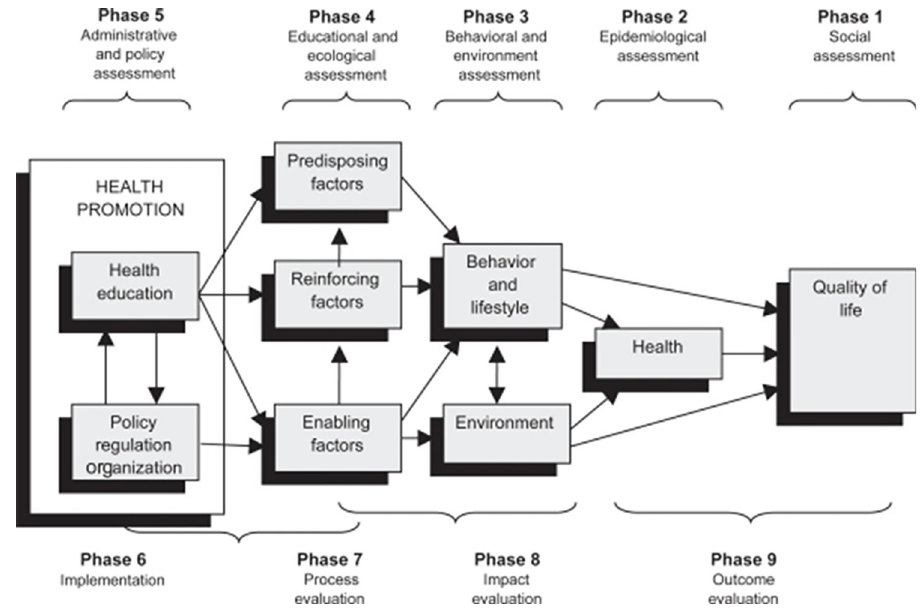
Fig 2. The PRECEDE-PROCEED model for health promotion, planning and evaluation